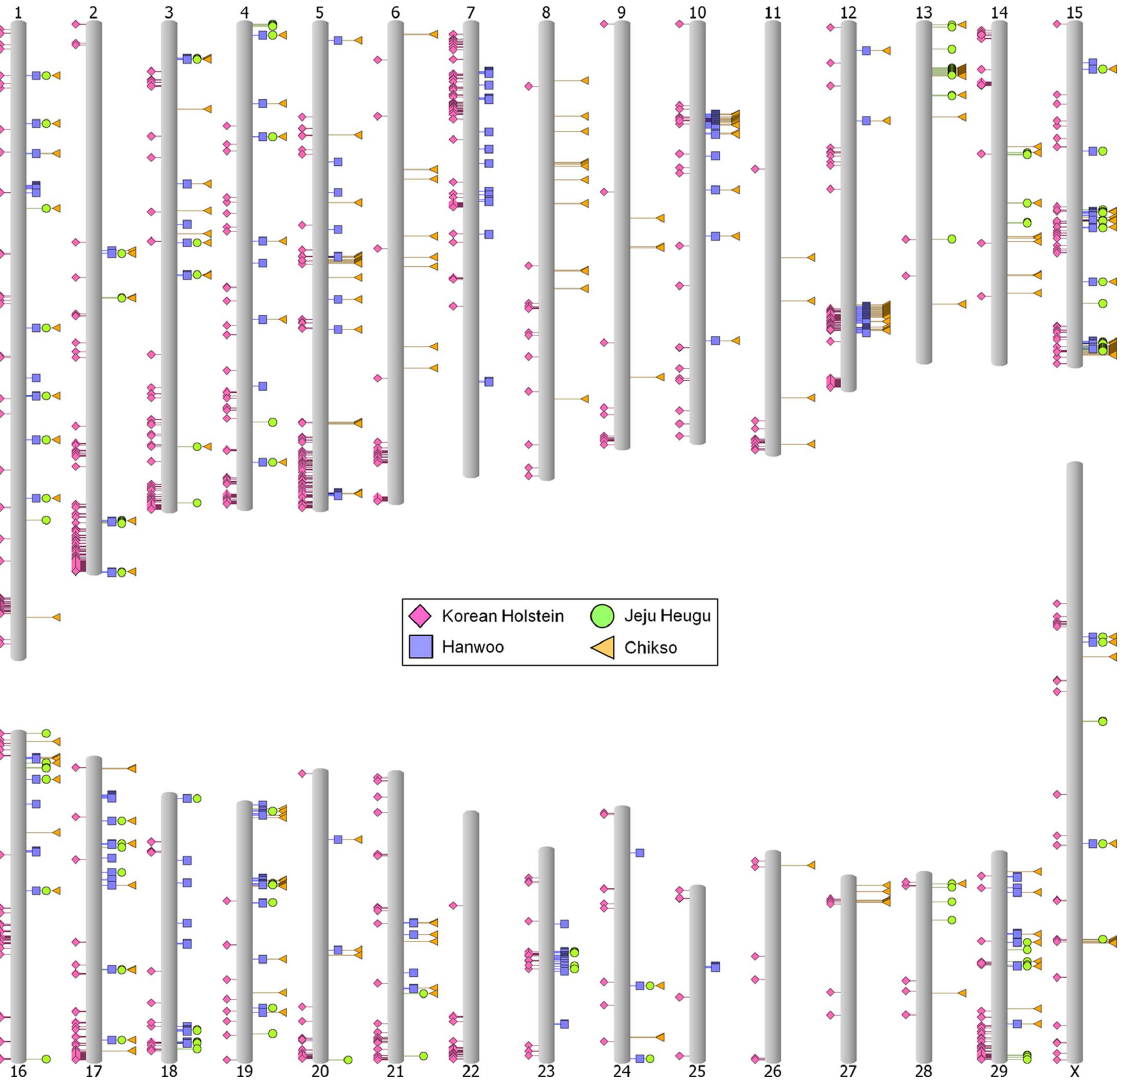
Figure 4. Distribution of copy number variation regions (CNVRs) on the chromosomes. Pink diamonds on the left of each chromosome indicate CNVR gains in Korean Holstein relative to Hanwoo, Jeju Heugu, and Chikso. Blue squares, green circles, and yellow triangles on the right represent CNVR gains in Hanwoo, Jeju Heugu, and Chikso, respectively.